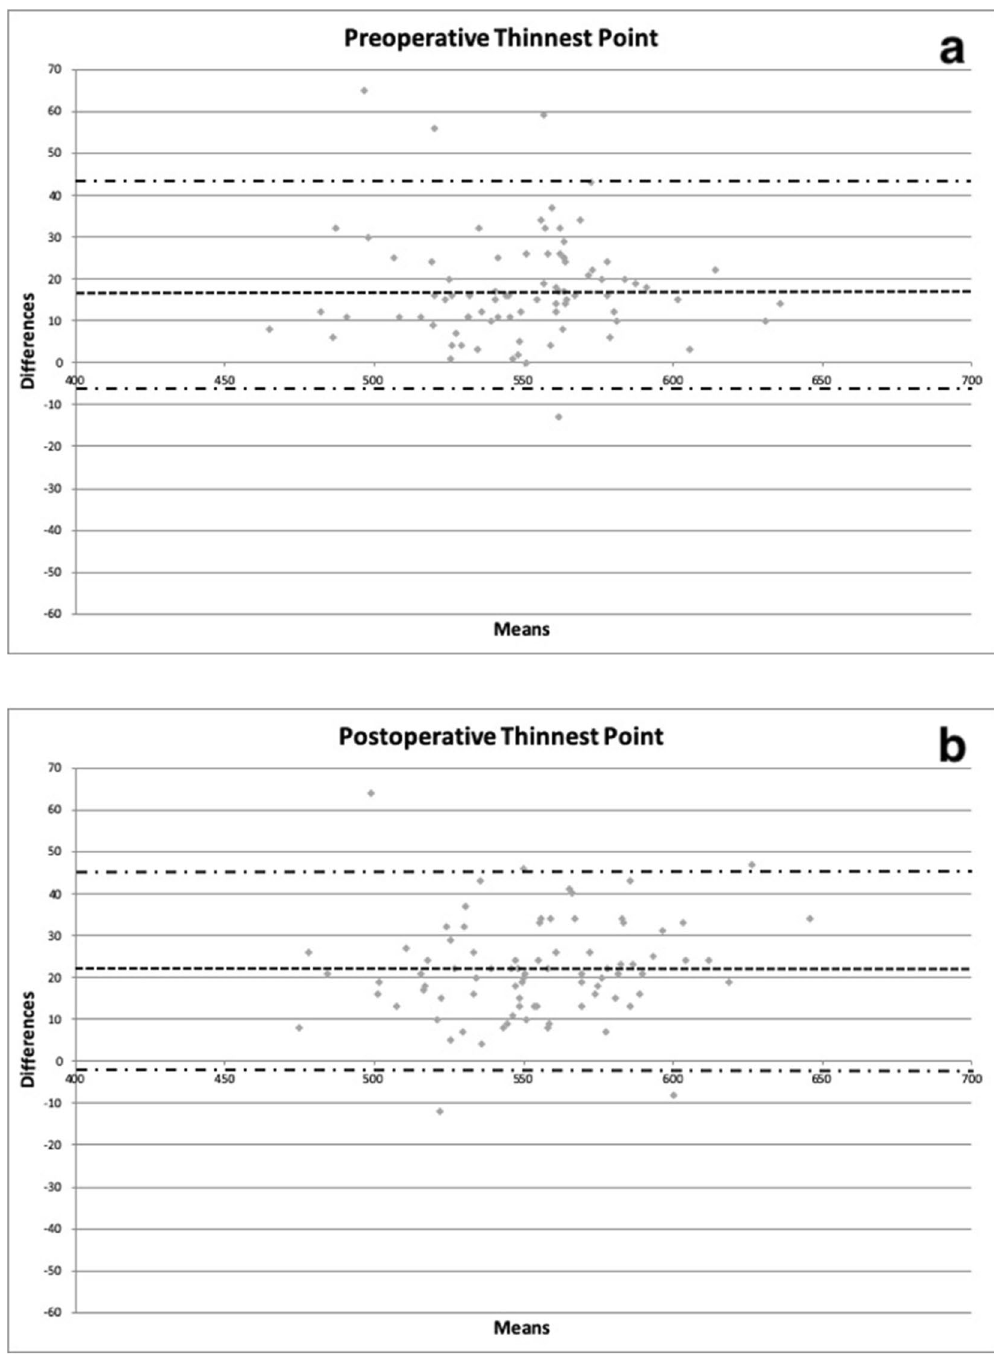
Figure 3. Bland–Altman plots between preoperative ( a ) and postoperative ( b ) corneal thickness in microns obtained with CEM-530 and Pentacam HR at the thinnest point. Dashed line: mean difference. Dash-dotted lines: mean ± 1.96 standard deviation of the differences. GPower: https:// www. psych ologie. hhu. de/ arbei tsgru ppen/ allge meine- psych ologie- und- arbei tspsy cholo gie/ gpower.